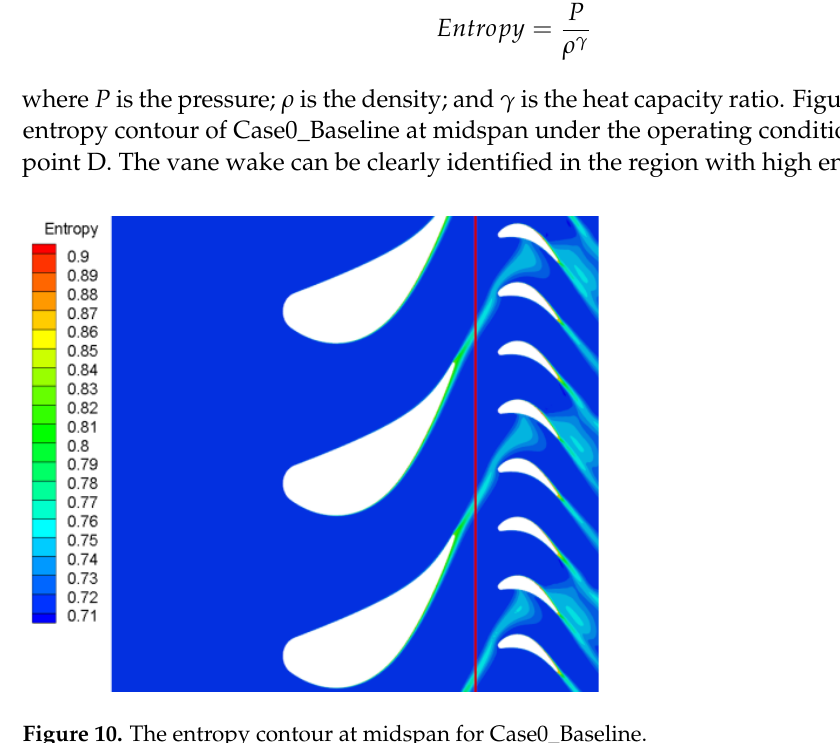
Figure 10. The entropy contour at midspan for Case0_Baseline. Extracting the wake profiles at the vane exit (red line in Figure 10) can help to shed light on the forcing aspect of the wakes. A comparison of the midspan wakes between Case0_Baseline and Case1_Asy97 running at the 3EO crossing (resonance point D) is shown in Figure 11. The horizontal coordinate represents the angle θ of the circumferential position, while the vertical coordinates are the entropy values. The entropy curve in Case0_Baseline (red line) shows periodic fluctuations in the circumferential direction and the entropy peaks represent viscous wakes with high losses. The 16 entropy peaks correspond to the 16 vane wakes, which are one of the sources of the 16EO excitation on the rotor blades. The offset in the circumferential position of the vane wakes in Case1_Asy97 (black line) indicates the effect of asymmetry relative to Case0_Baseline. The spatial spectrum provides a clearer view of the variation in the wake profile under the asymmetric vane configuration. Figure 12 shows the entropy spatial spectra of Case0_Baseline and Case1_Asy97 running at resonance point